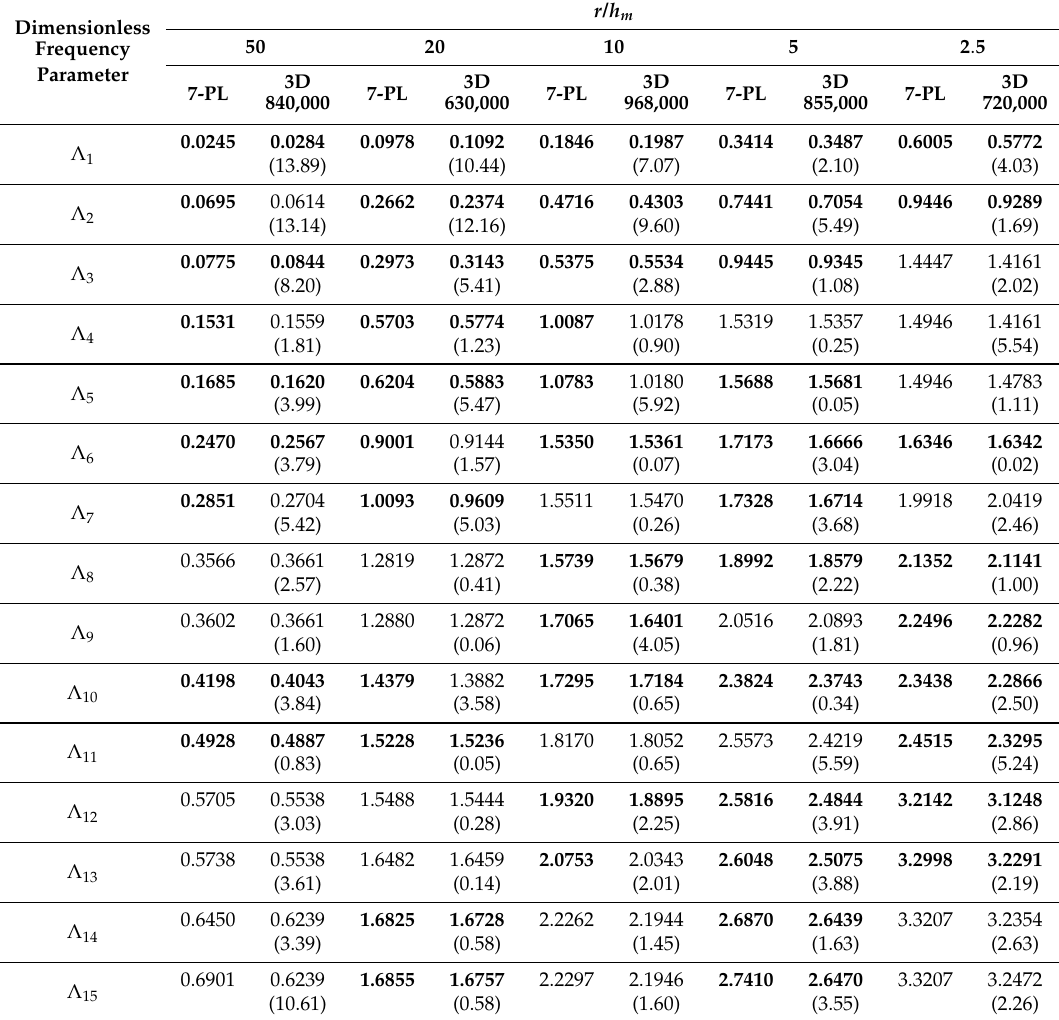
Table 17. Dimensionless natural frequencies parameter for an hemisphere with linear thickness variation and FF boundary conditions, h 1 / h 0 =